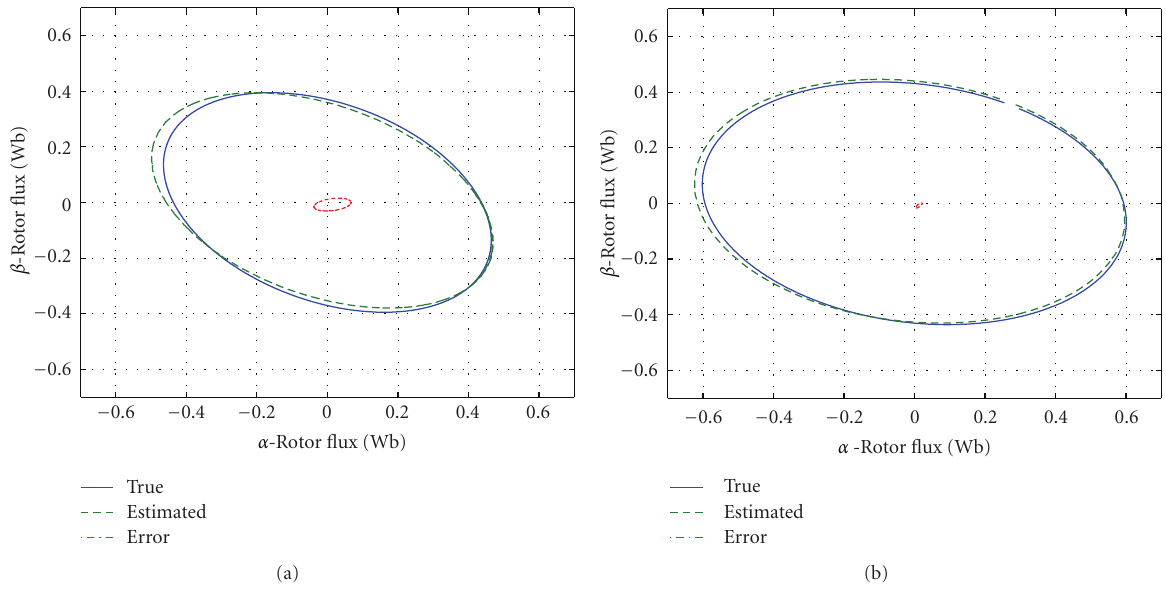
Figure 6: Phase portrait λ rα × λ rβ of the vector rotor flux of no-load SPIM (computational simulation): (a) 10Hz, (b) 50Hz.